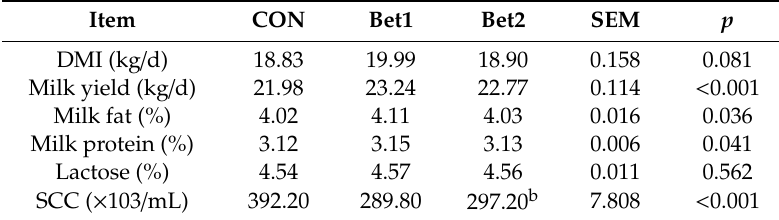
Table 2. E ff ect of betaine on lactation performance of dairy cows. Item